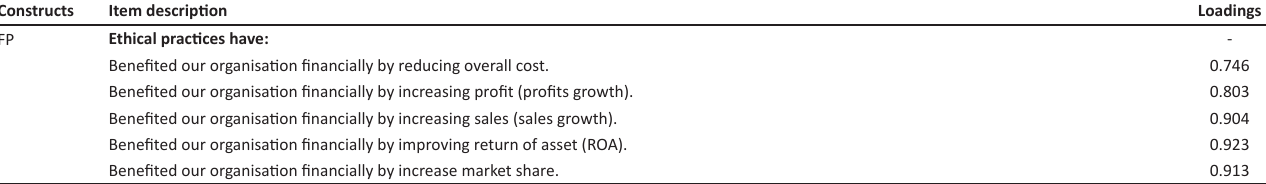
TABLE 1(Continues...): List of items with factor loading.